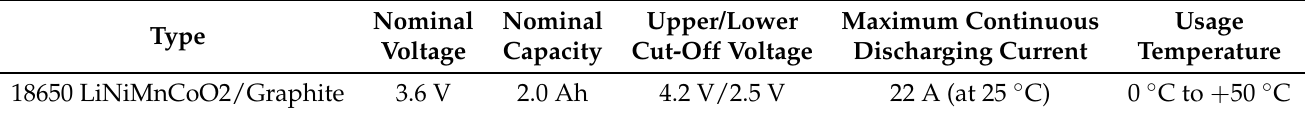
Table 2. INR 18650-20R cell